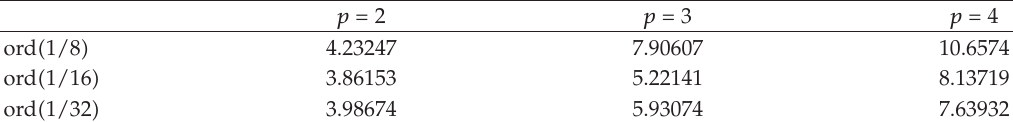
Table 5: Observed orders of Example 3.1 for n (cid:5) 2 at x (cid:5) 1 / 2 using Taylor’s decomposition